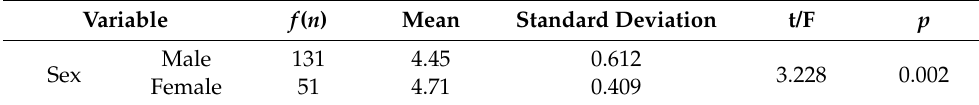
Table 5. Management factors in relation to the respondents’ personal and professional characteristics.